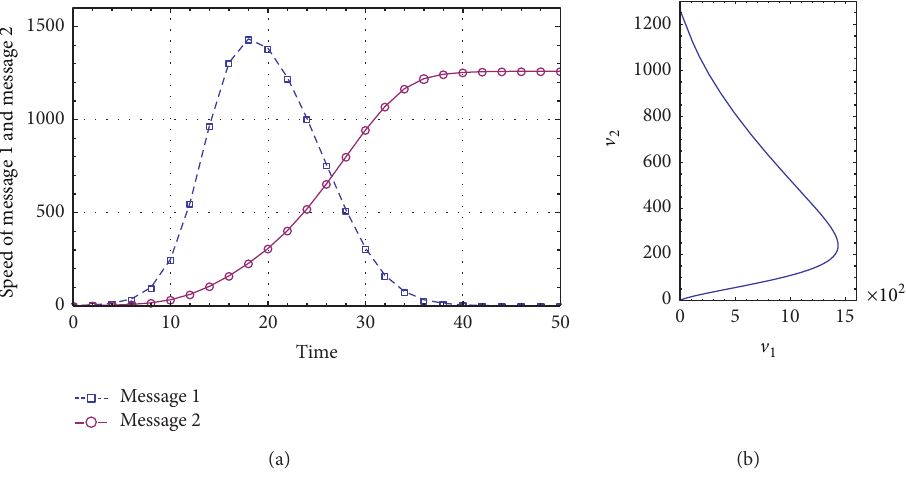
Figure 9: (a) V 1 and V 2 as a function of 𝑡 , with V 1 (0) = 2 , V 2 (0) = 1 , 𝑉 1 = 3000 , 𝛼 = 80 , 𝜎 9(𝑎) 12 = 0.6 , 𝜇 1 = 0.7 , 𝜆 1 = 0.2 , 𝑉 2 = 1800 , 𝛽 = 20 , 𝜎 9(𝑎) = 2 , 𝜇 = 0.5 , and 𝜆 = 0.15 . (b) The development trend of relationship between message 1 and message 2 2 21